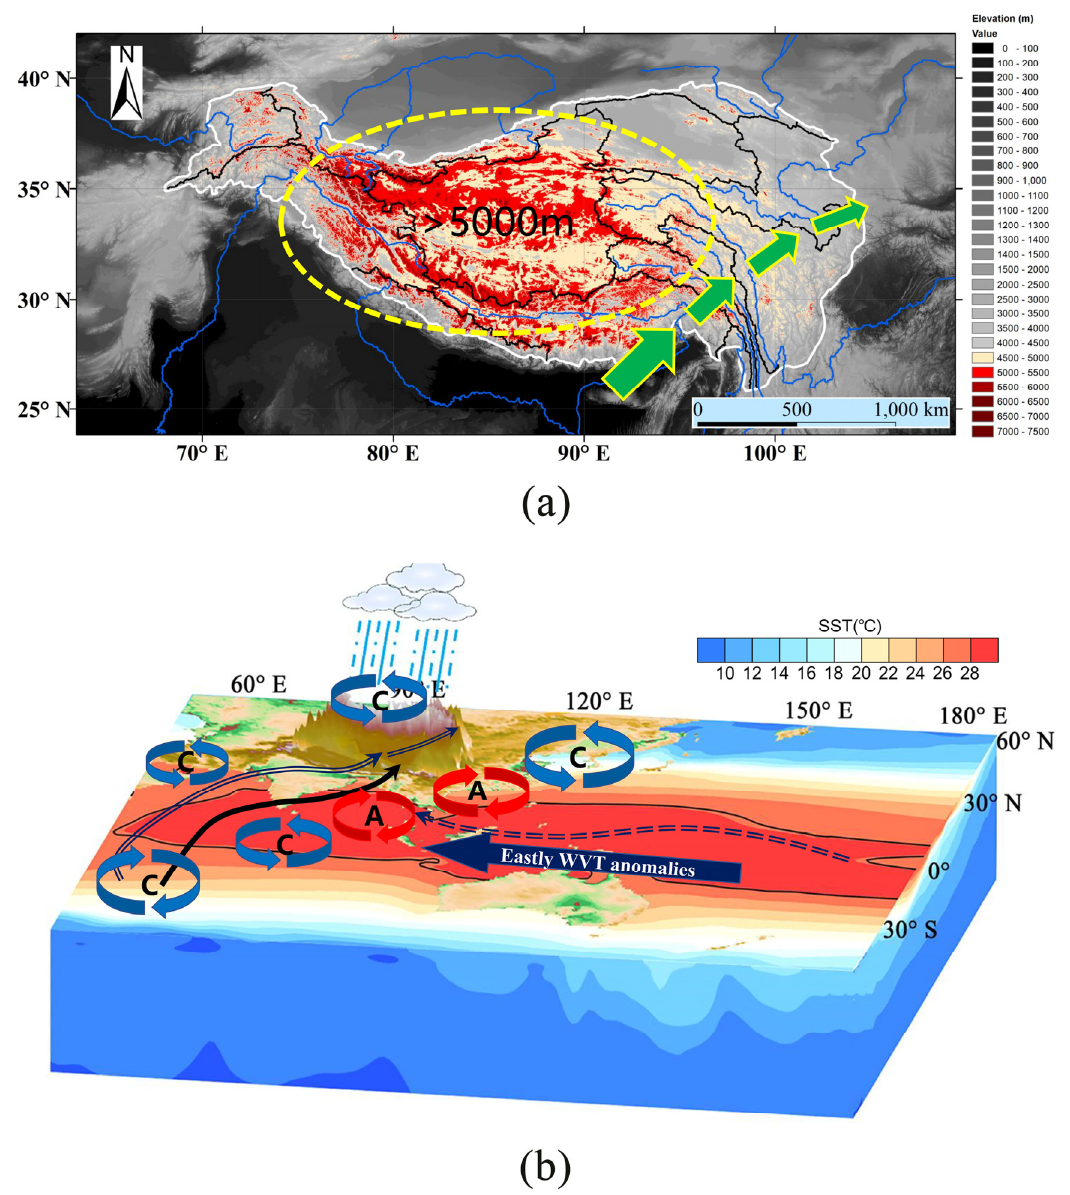
Figure 15. ( a ) The water vapor transport channel in the southeastern TP (Arrows) and its relationship with the topography. ( b ) Schematic diagram of summer WVT over the TP associated with the air-sea changes in the IPWP. The black line denotes the climatic WVT channel from the IPWP to the TP, and the blue solid line denotes the anomalous WVT of the channel, which directly enhances the WVT channel. The blue dotted line denotes the anomalous WVT, which indirectly suppresses the WVT channel. The letters A and C indicate anticyclone and cyclone, respectively.